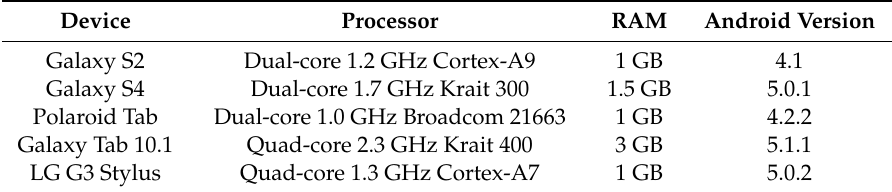
Table 1. Devices utilized for testing the proposed application.